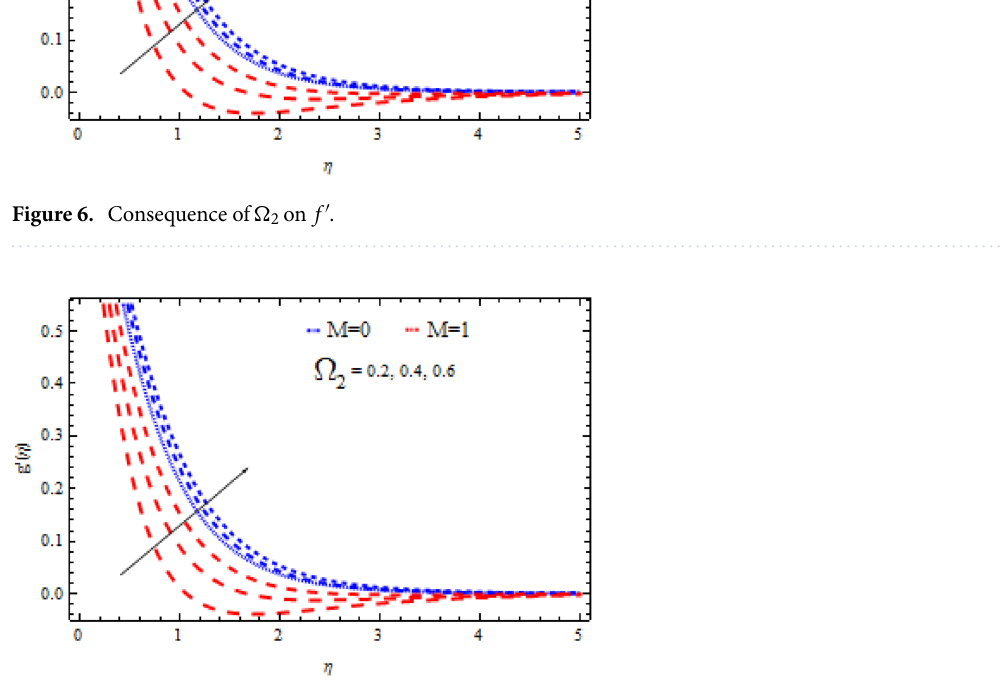
Figure 7. Consequence of (cid:31) 2 on g ′